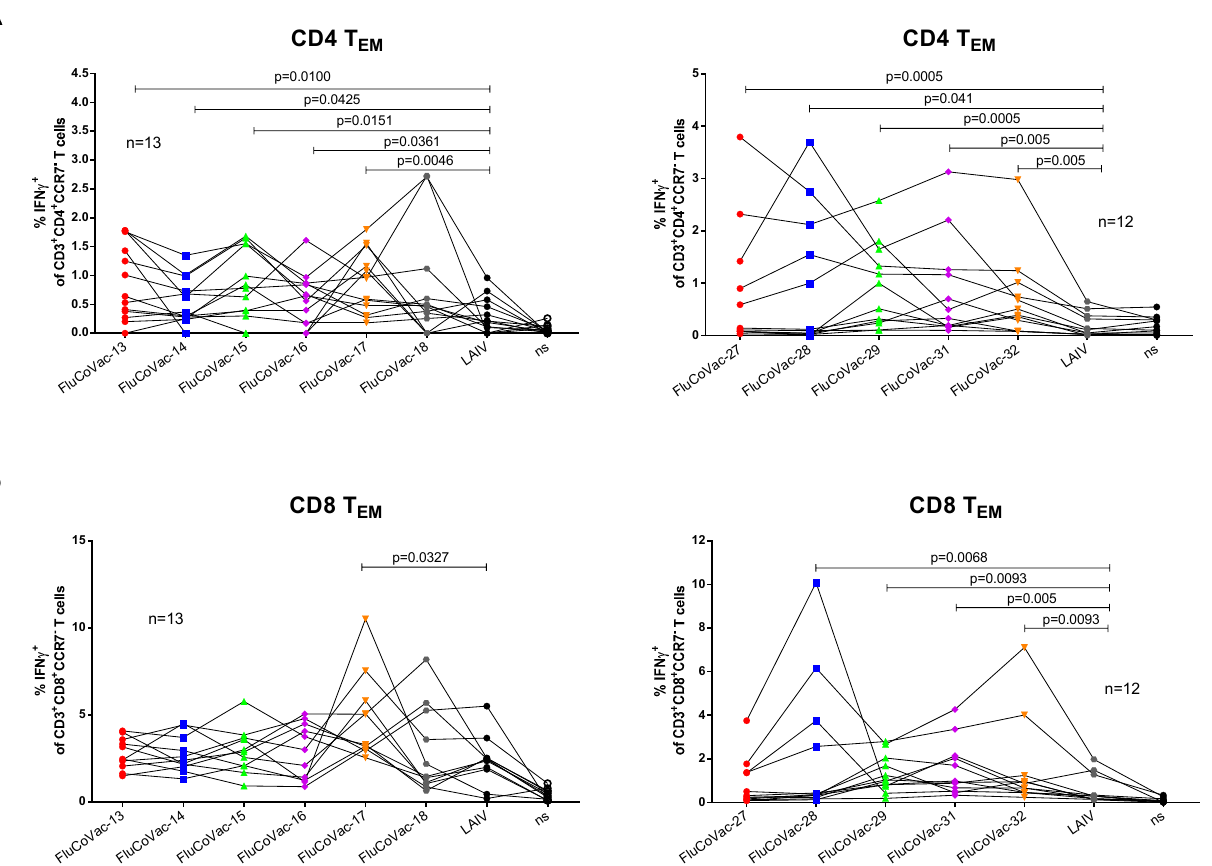
Figure 5. The levels of cytokine-producing effector memory T cell subsets in PBMC samples were stimulated with the studied recombinant LAIV/SARS-CoV-2 viruses. ( A ) CD4 T EM cells. ( B ) CD8 T EM cells. Upper and lower panels demonstrate the results of experiment #1 and #2, respectively. Differences between the levels of IFN γ -secreting T cells between LAIV vector and LAIV/SARS-CoV-2 recombinant viruses were assessed by non-parametric analysis using the Wilcoxon matched pair test.